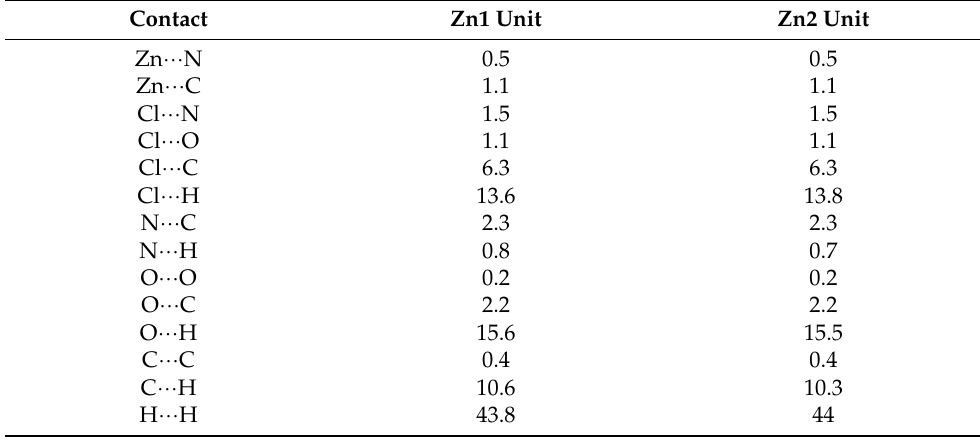
Table 6. Different contacts and their percentages in complex 1